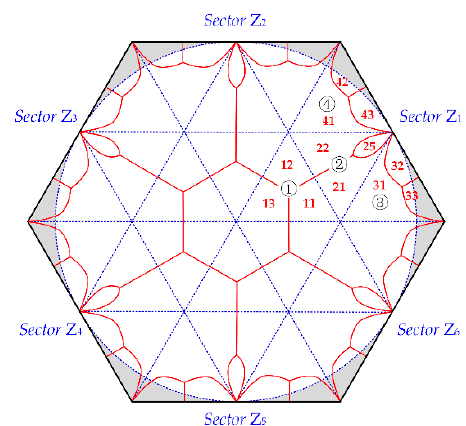
Figure 6. The optimal distribution of switching sequences for the proposed sector subdivision based SVPWM strategy in space vector diagram (all six sectors).